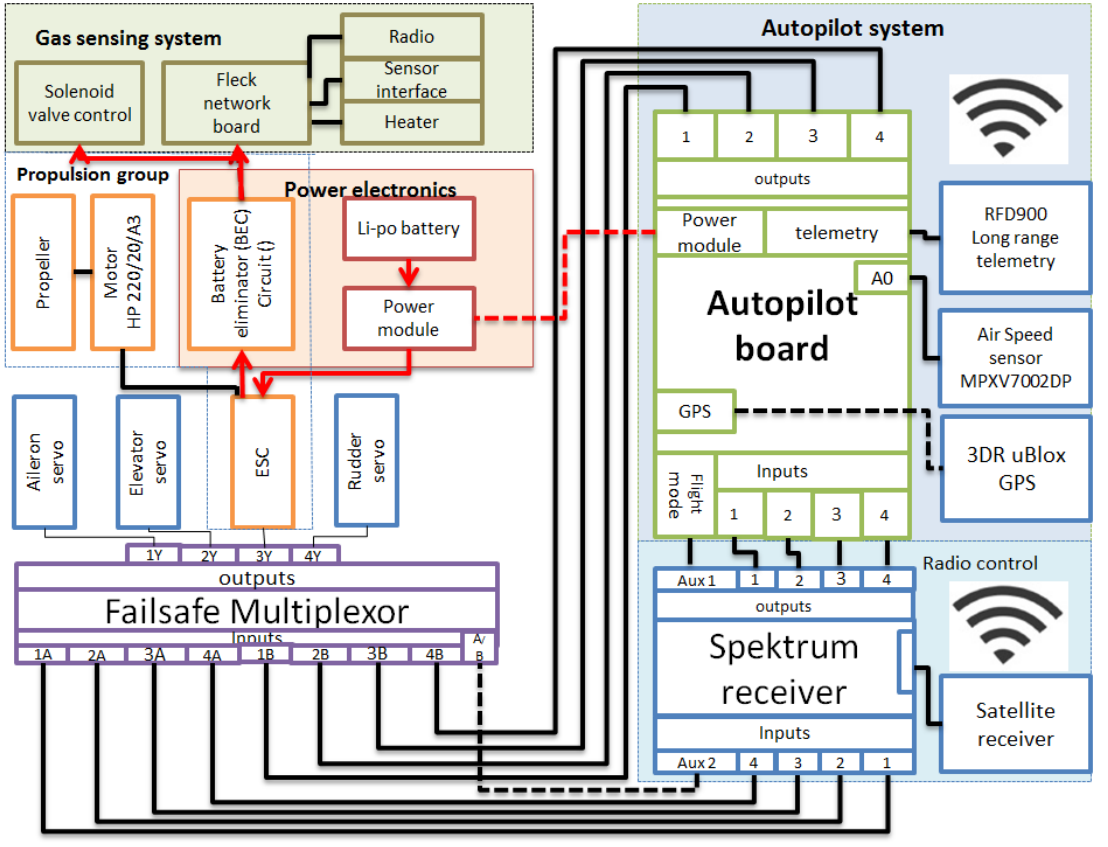
Figure 7. Configuration of the four main sub-systems integrated in the